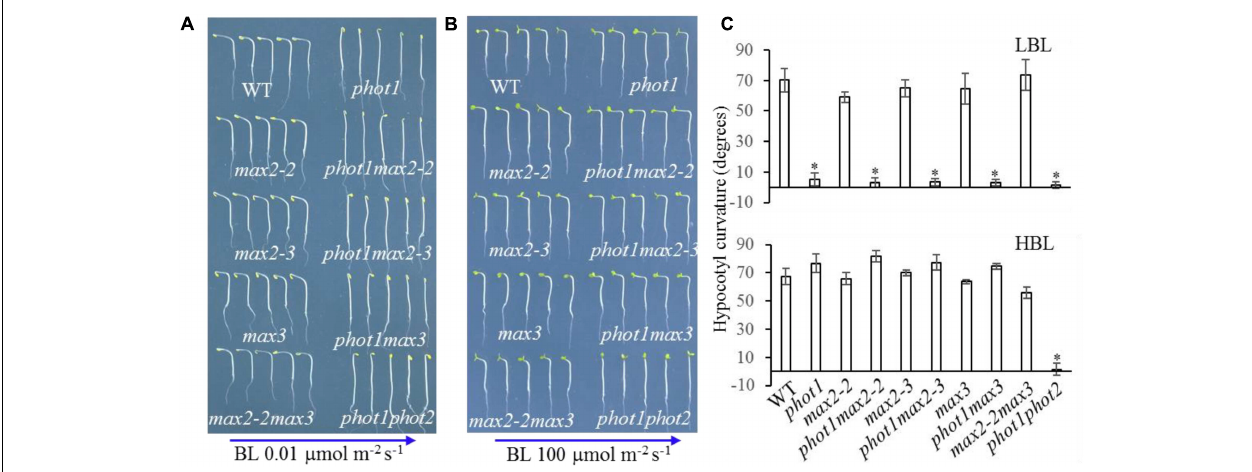
FIGURE 6 | Hypocotyl phototropism of WT and mutant seedlings. (A,B) Three-day-old etiolated WT and mutant seedlings were irradiated with blue light at (A) 0.01 µ mol m − 2 s − 1 or (B) 100 µ mol m − 2 s − 1 for 12 h. (C) Hypocotyl curvatures of seedlings in panels (A,B) . Each bar represents an average of three experiments (15–20 measurements per experiment) ± SD. ∗ P < 0.05.